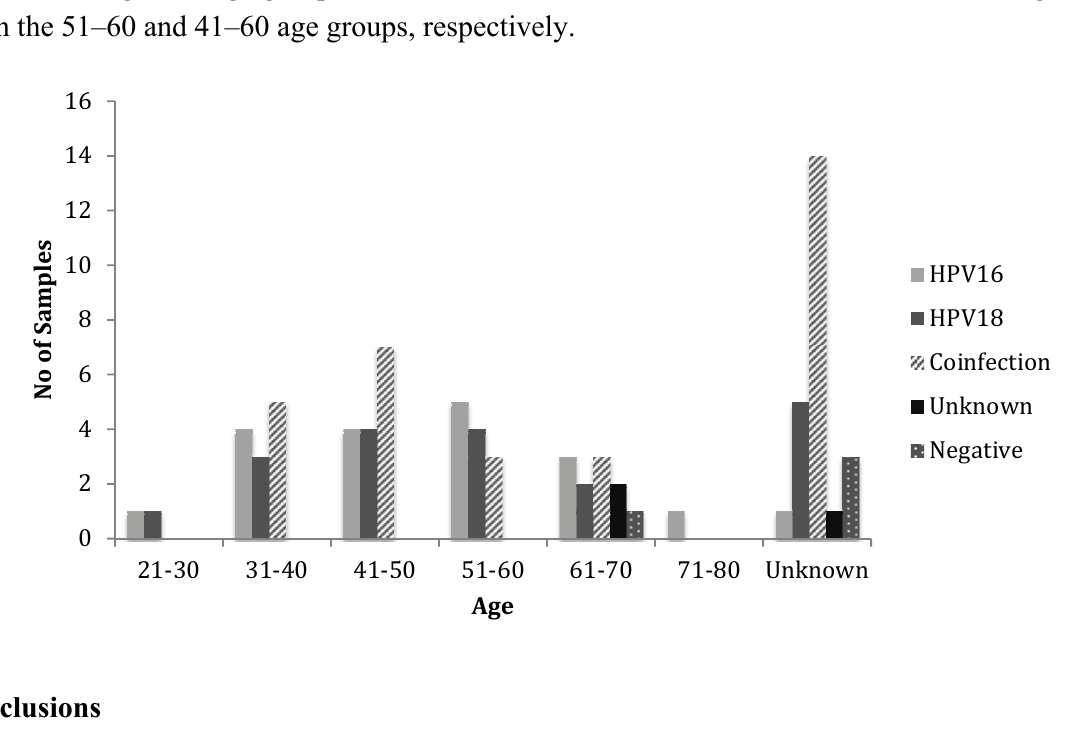
Figure 5. Genotypic distribution of HPV in cervical carcinoma samples in correlation with age. The maximum incidence of cervical carcinoma was found in age group